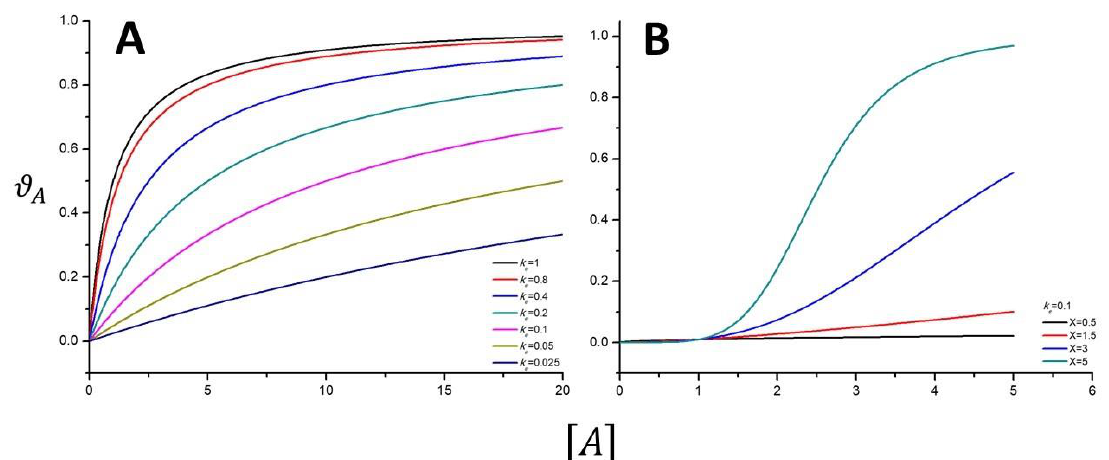
Figure 13. ( A ) Langmuir isotherms obtained by simulation of Equation (32). The different curves have been acquired by using the value of the equilibrium constant reported in the graph. ( B ). Langmuir isotherms obtained by simulation of Equation (33). The different curves were obtained by fixing the k e value to 0.1 and by using the X values reported in graph.